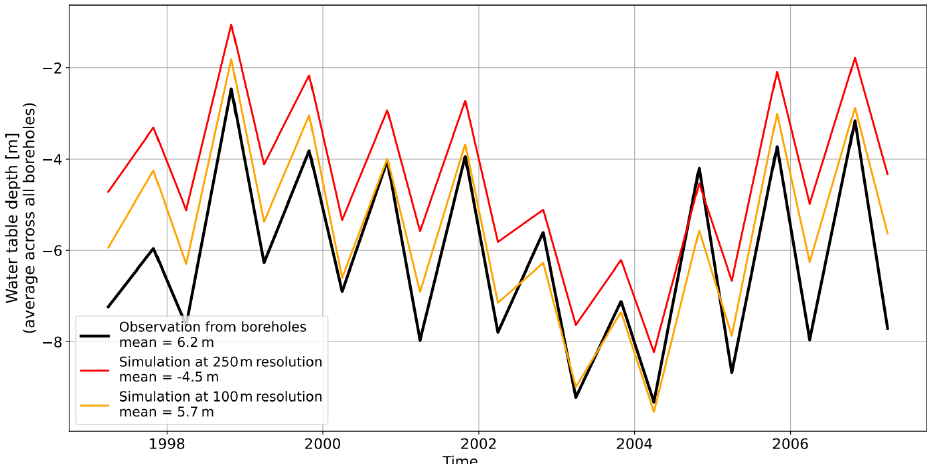
Figure 8. Comparison between simulated water table depth using a groundwater model resolution of 250 and 100m in the Bhima basin. Black lines represent observed data. Water table depth fluctuations are aggregated from 351 boreholes. Note how improving the resolution reduces the water